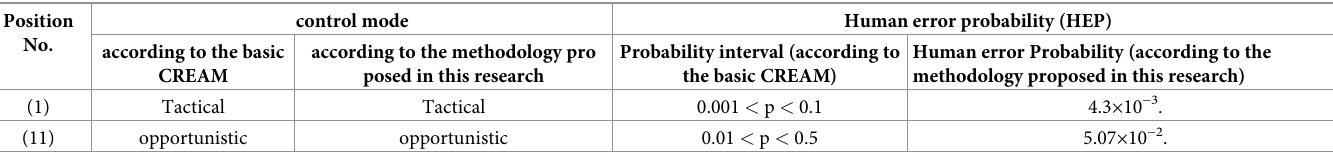
Table 7. Comparison of the results from the basic CREAM with the results based on the quantified methodology. Position No.